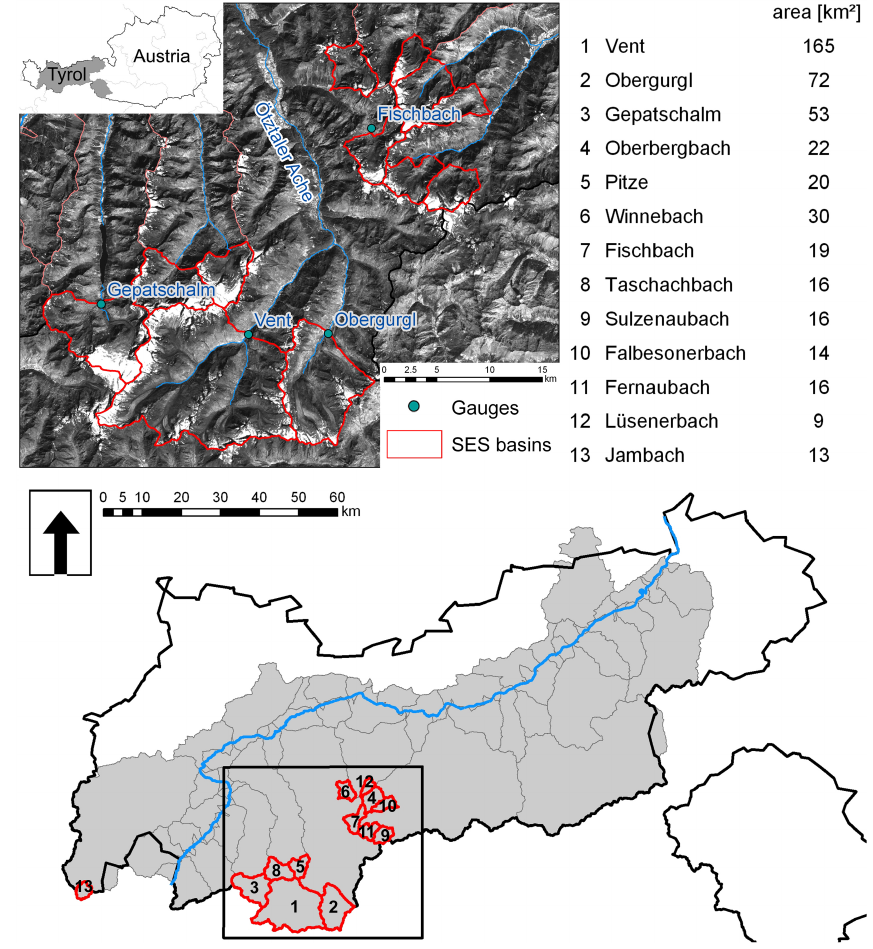
Fig. 1. Basin of the river Inn in Tyrol/Austria: tributary catchments are displayed in gray (HQsim), boundaries of the glacierized headwaters are highlighted in red